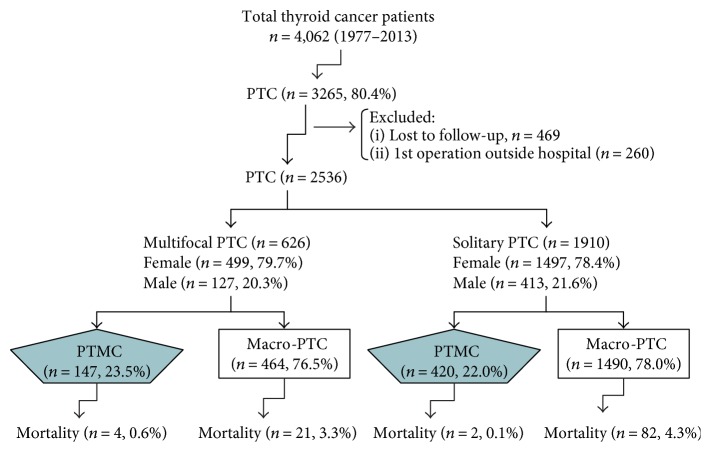
Distribution of papillary thyroid carcinoma patients in the current study. PTC: papillary thyroid cancer; PTMC: papillary thyroid microcarcinoma.